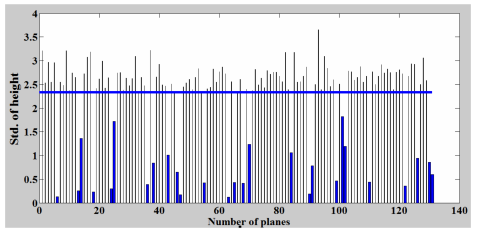
Figure 4: Standard deviation (std.) of height of all the extracted planar segments. Black and blue vertical lines represent std. of height from trees and buildings respectively. The blue horizontal line corresponds to the average std. of height.